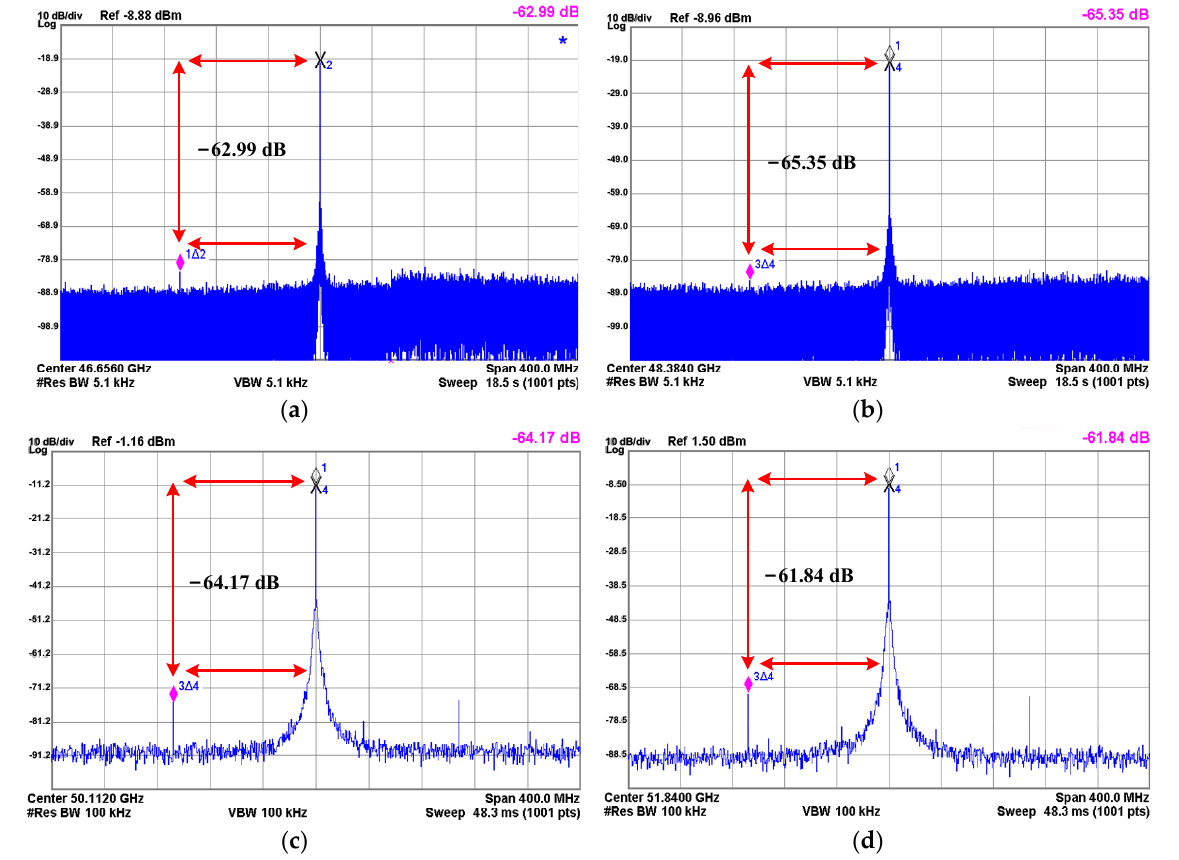
Figure 17. Measured phase noise of the PLL: ( a ) 46.656 GHz; ( b ) 48.384 GHz; ( c ) 50.112 GHz; ( d ) 51.840 GHz.